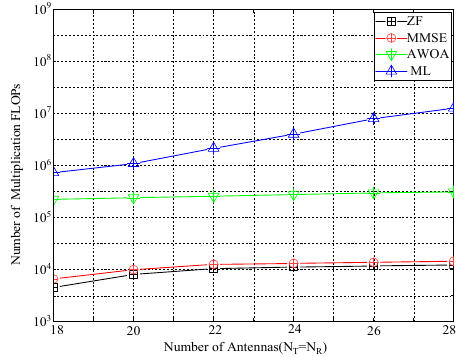
Figure 13. The comparison of FLOPs.